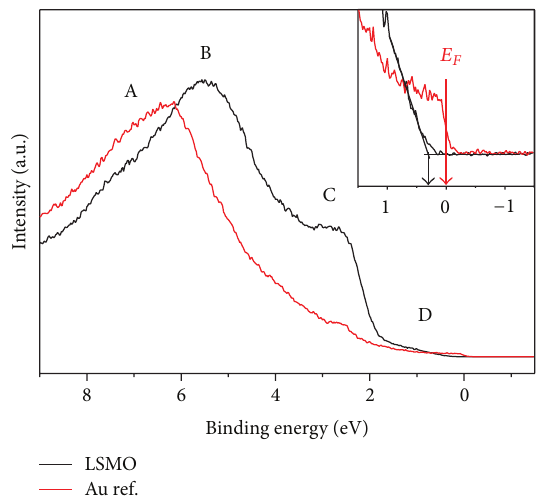
Figure 4: Valence band spectra of the LSMO thin film and reference Au. Inset corresponds to expanded data in the vicinity of the Fermi